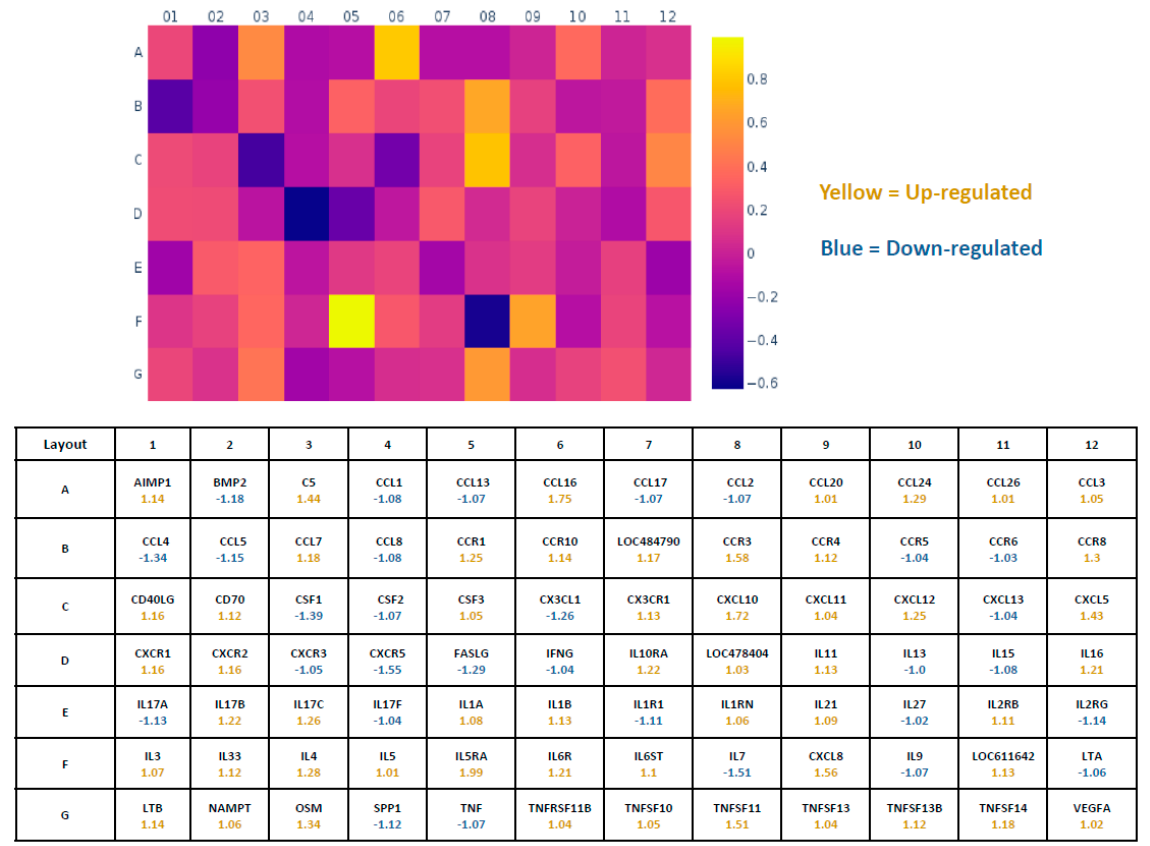
Figure 4. Heat map showing the fold change in gene expression in CKD dogs ( n = 10) when compared to controls ( n = 10). The individual squares in a heat map are scaled with a range of colors proportional to gene expression values. The figure below (Rows A to G) corresponds to the squares above, and each square indicates the average values for that gene, with numerically positive values indicating up-regulation and negative values indicating down-regulation. Row H (not shown) included the housekeeping genes ACTB, B2M, GAPDH, HPRT1, and RPLP in the assay. Other controls in row H included those for detection of genomic DNA contamination, reverse transcription control, and positive PCR control. As mentioned in Figure 3, data are presented as mean fold change ( ∆∆ Ct) normalized to the housekeeping gene, HPRT1.